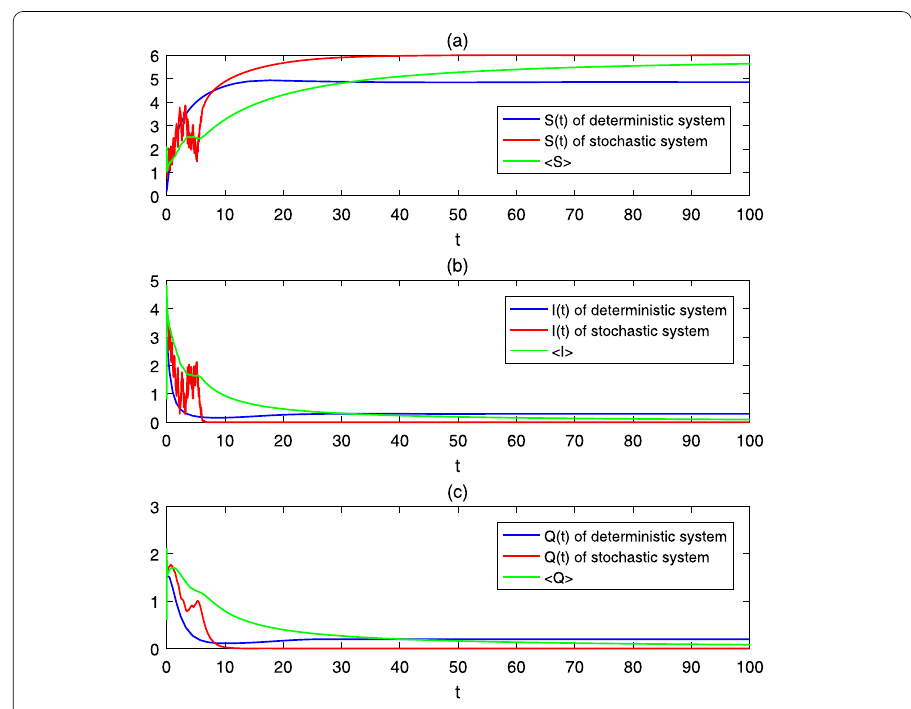
Figure 3 Comparison of system (2) and system (3), u = 0.32, δ = 0.58, β = 0.3, b = 0.2, q = 0.26, ε = 0.32, α